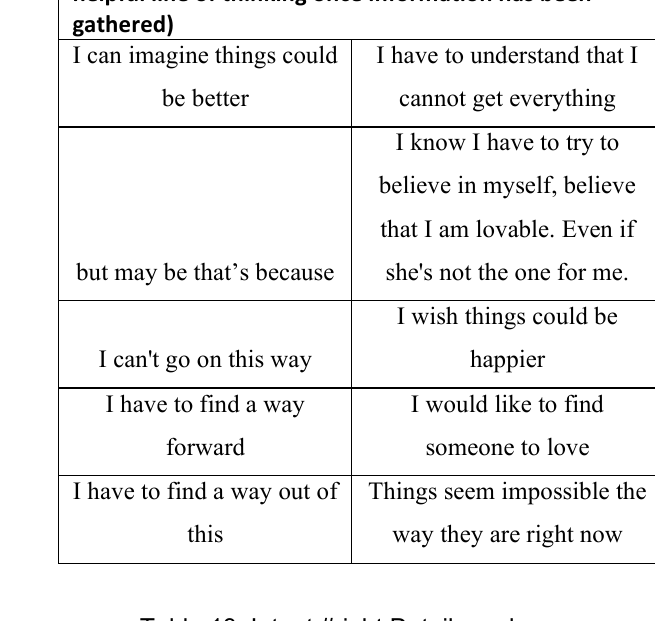
Table 13. Intent #right Details and case examples